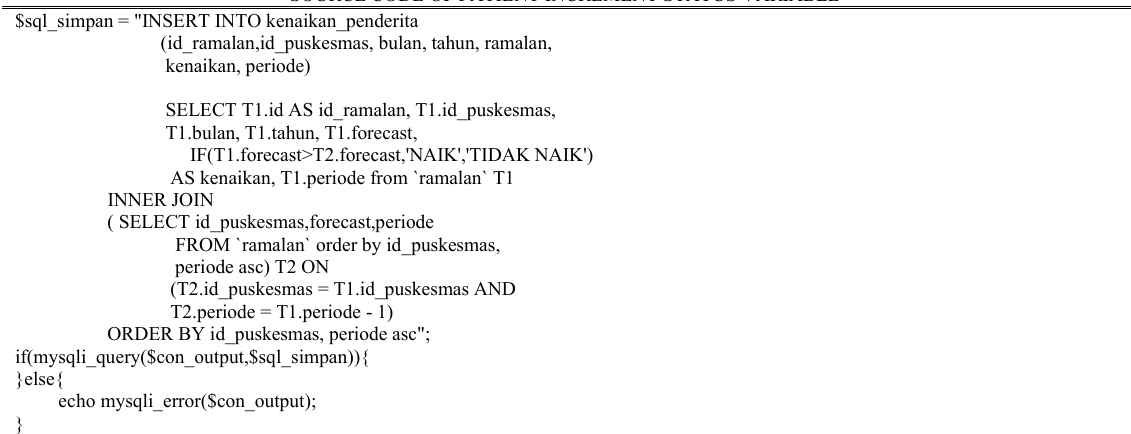
TABLE 11 SOURCE CODE OF PATIENT INCREMENT STATUS